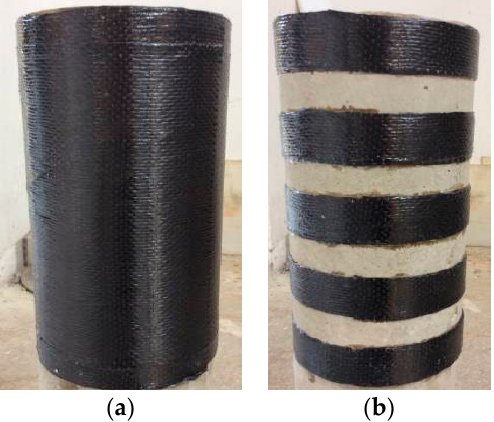
Figure 1. Fully and partially FRP-confined concrete. ( a ) Fully FRP-confined concrete; ( b ) Partially FRP-confined concrete.